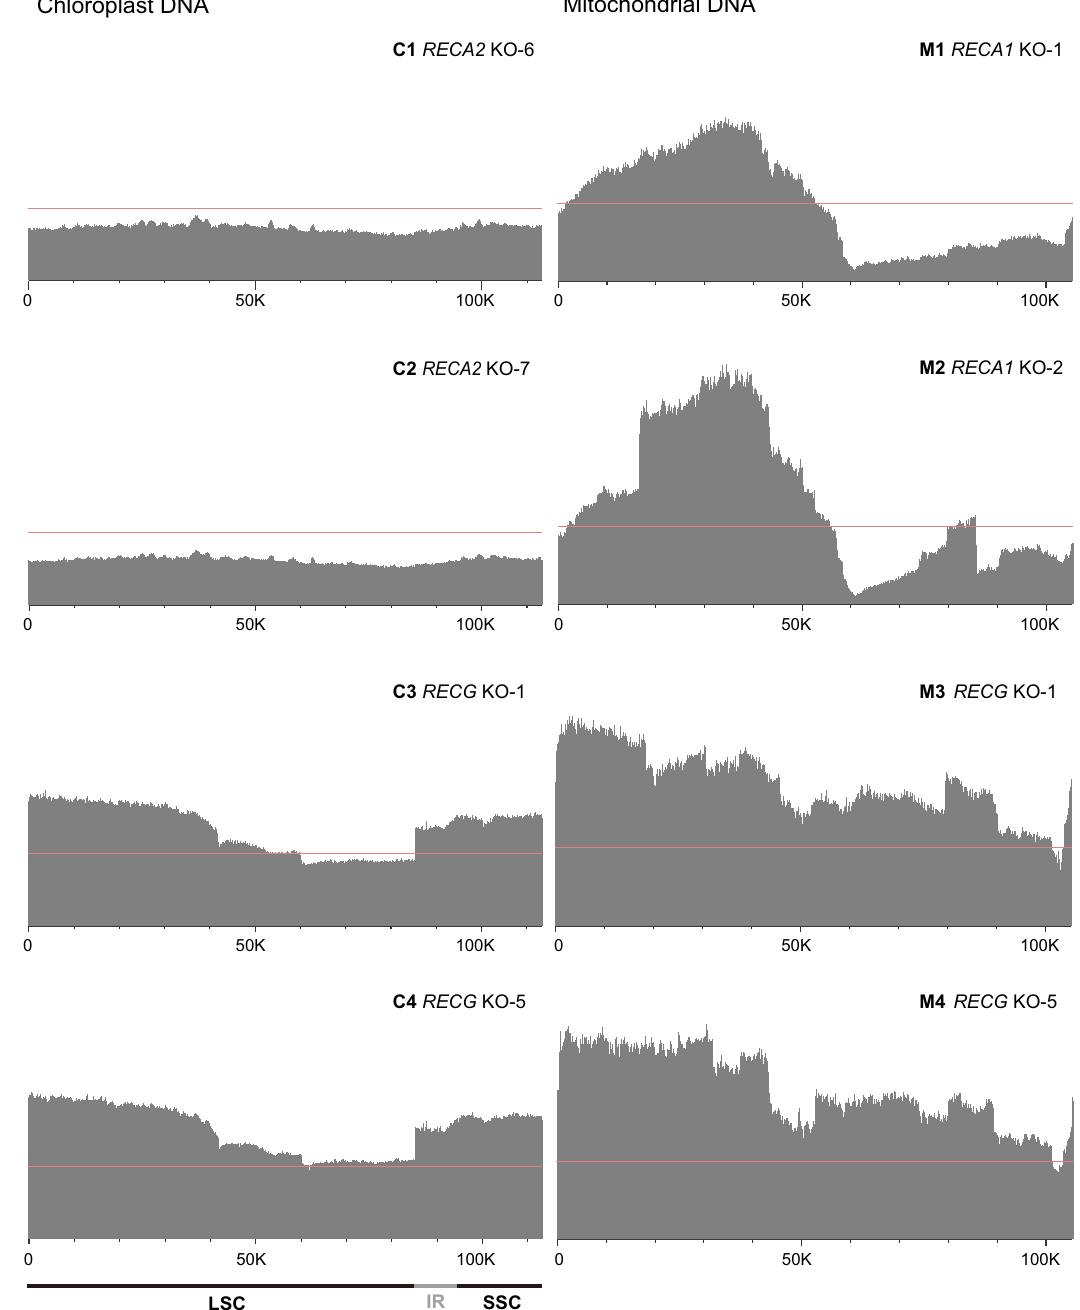
Fig. 2 Mapping depth of mutant organelle DNA. Mapping results of mutant chloroplast DNA ( a ) and mitochondrial DNA ( b ). Mapped reads of mutant cpDNA and mtDNA were normalized against those of WT cpDNA and mtDNA, respectively. Red line indicates the average depth expected from relative copy number among cpDNA and mtDNA in WT. One copy of the large inverted repeats was removed from the cpDNA